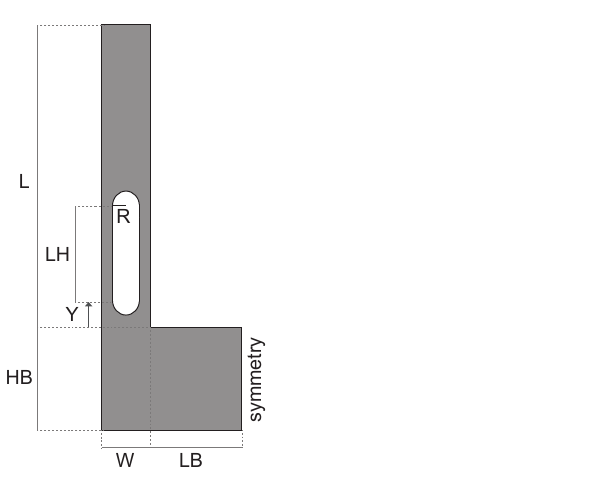
Figure 9. Tuning fork resonator with one hole: geometric dimensions defining the